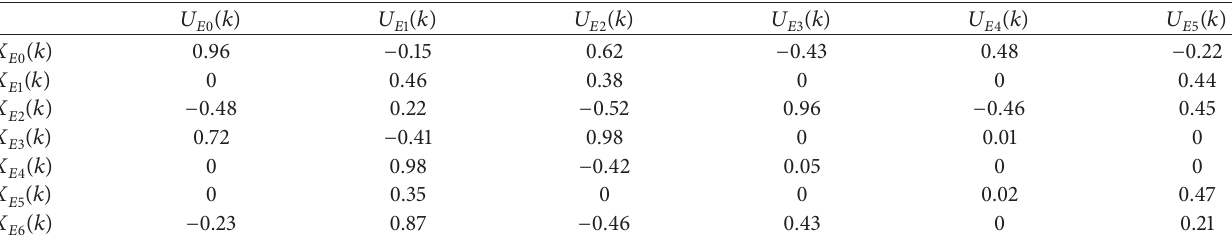
of the sensitivity of internal stimuli. YM